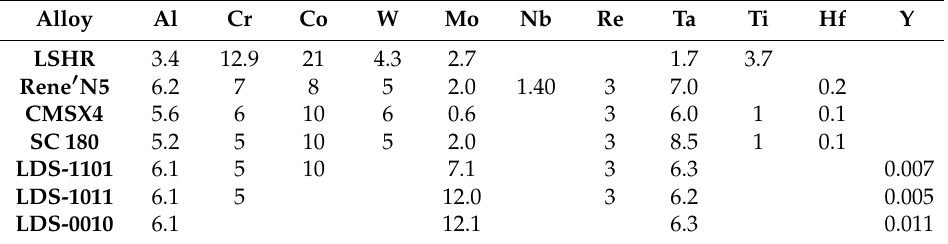
Table 1. Nominal composition of superalloys in low temperature hot corrosion (LTHC) test series. Low solvus high refractory (LSHR) disk alloy, commercial single crystals, and experimental Low Density Superalloy (LDS) high-Mo